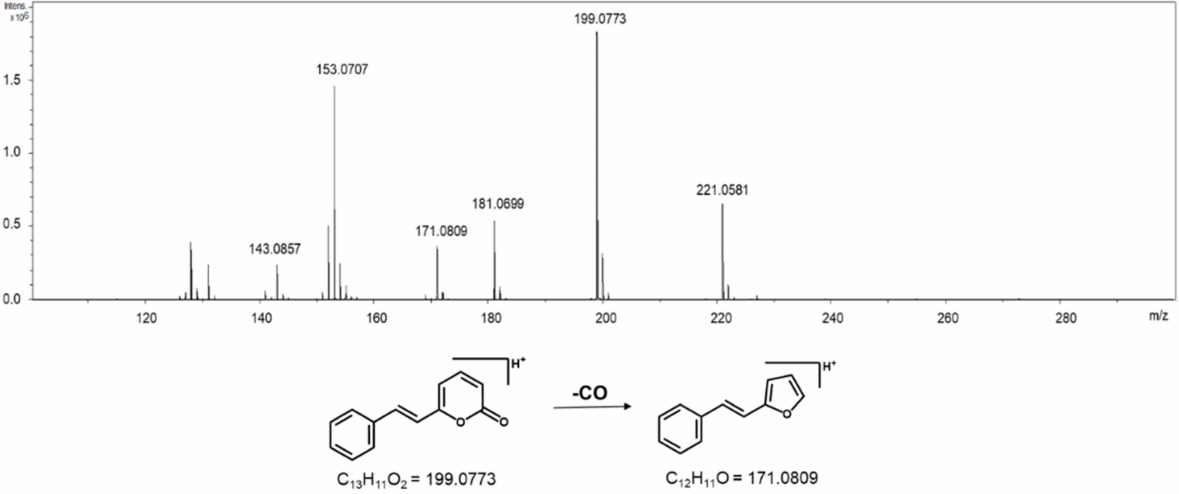
Figure 3. High resolution mass spectrum of 6-styryl-2-pyrone [M + H] + = 199.0773 and its fragmentation pathways. The PCA also indicated the distinction in the chemical profiles of bark samples from other tissues for FLONA samples, described by PC-2 (Figure 1B). This difference is due to the presence of reticuline, a benzylisoquinoline alkaloid in the trunk of Aniba species [18]. The isomers of reticuline were identified at RT 3.29 and 2.10 min by m / z 192.1012, which resulted from the fragmentation of [M + H] + 330.1700 corresponding to reticuline (C 19 H 23 NO 4 ; calculated [M + H] + 330.1699). The fragmentations indicated the initial loss of methylamine, forming an ion of m/z 299.1272, followed by fragmentation